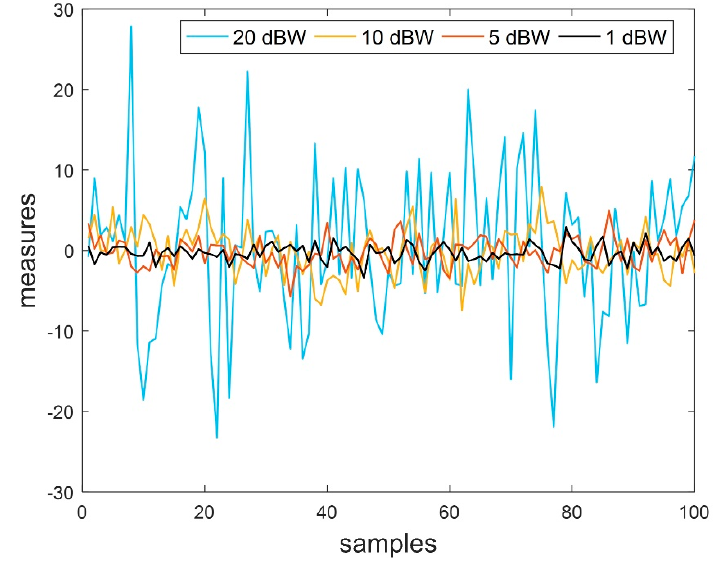
Figure 3. Noise-only measurements at different noise power levels.